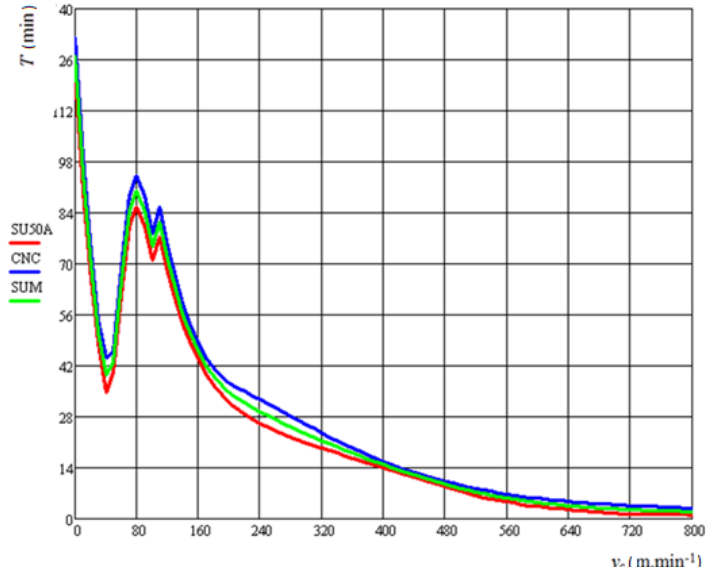
Figure 18. T-vc dependence—an average of all tested materials for conventional lathe and CNC machine.